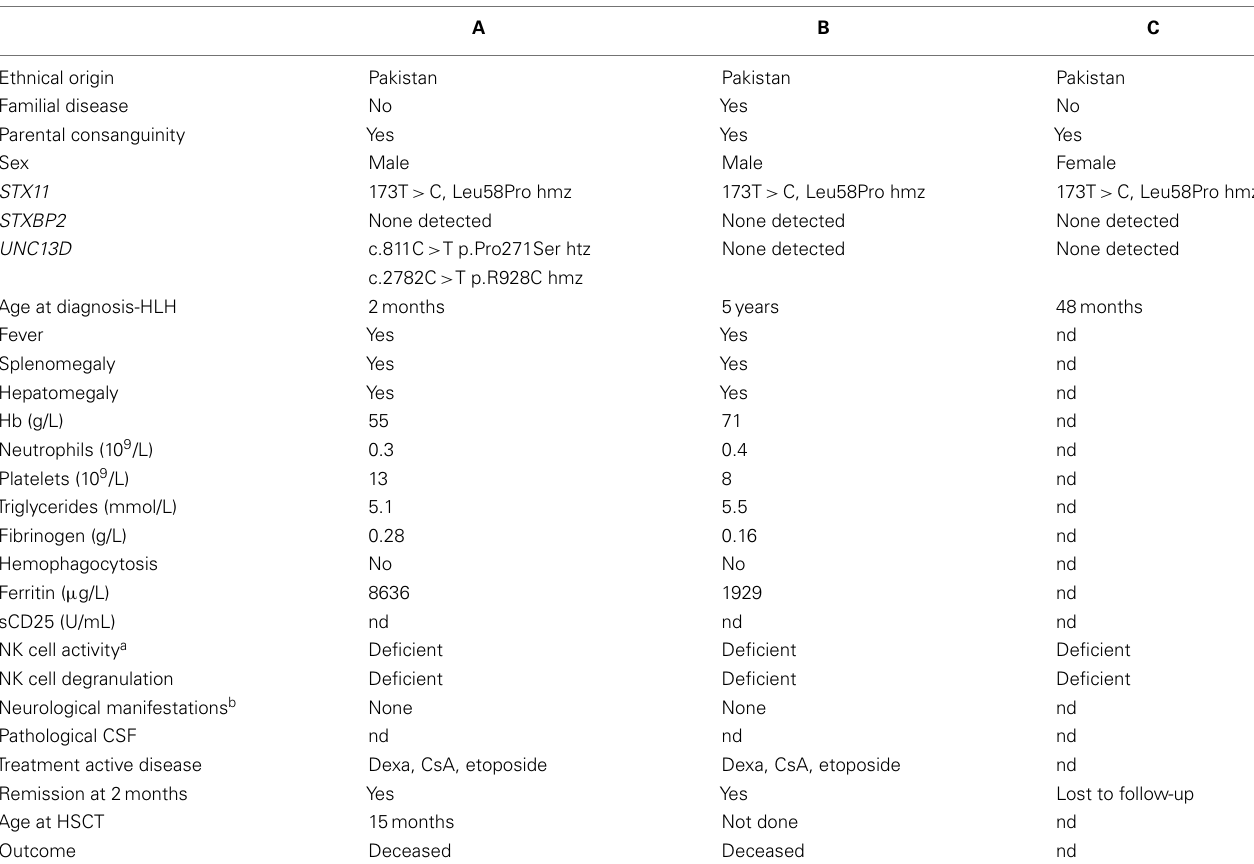
Table 1 | Clinical, laboratory, and genetic findings in